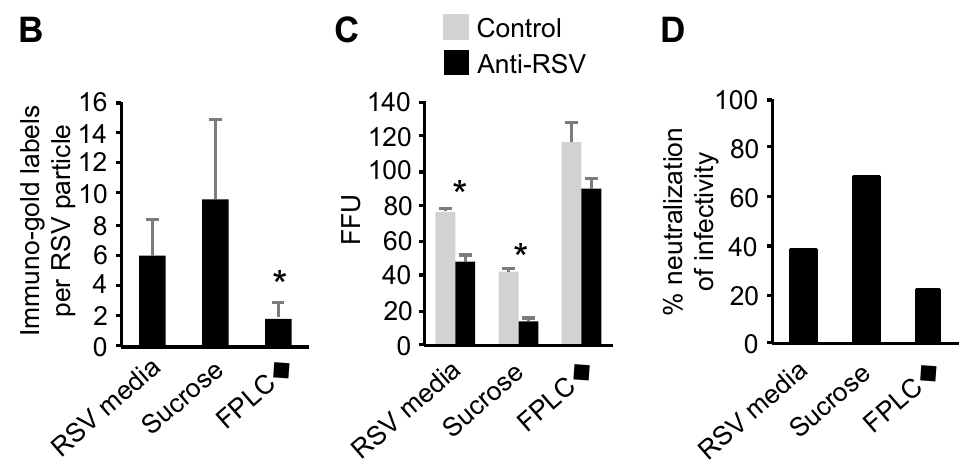
Figure 4. Imaging RSV stocks by transmission electron microscopy and measuring their susceptibility to antibody neutralization. ( A ) Unpurified virus (RSV media) and sucrose- and FPLC -purified RSV stocks were immuno-labeled, negatively stained, and then imaged by transmission electron microscopy. A representative image of each is shown with black arrows indicating anti-RSV immuno-gold particles. The scale bar is 100 nm long; ( B ) The immuno-gold dots bound to twenty-five virus particles from the transmission electron microscopy imaging of each purification method were counted. * p < 0.05 by Tukey’s test of significance; ( C , D ) Equivalent infectious units of unpurified virus (RSV media), sucrose ultracentrifugation-purified, and FPLC -purified stocks were incubated with 2 μ g/mL anti-RSV polyclonal antibody and then added to HeLa cells for 20 h before being fixed and stained for RSV infection; ( C ) Focus forming units were manually counted and are represented as FFU per well. * p < 0.05 by Student’s t test. The neutralization as a percentage of control FFU/mL of each preparation is shown in panel ( D ).